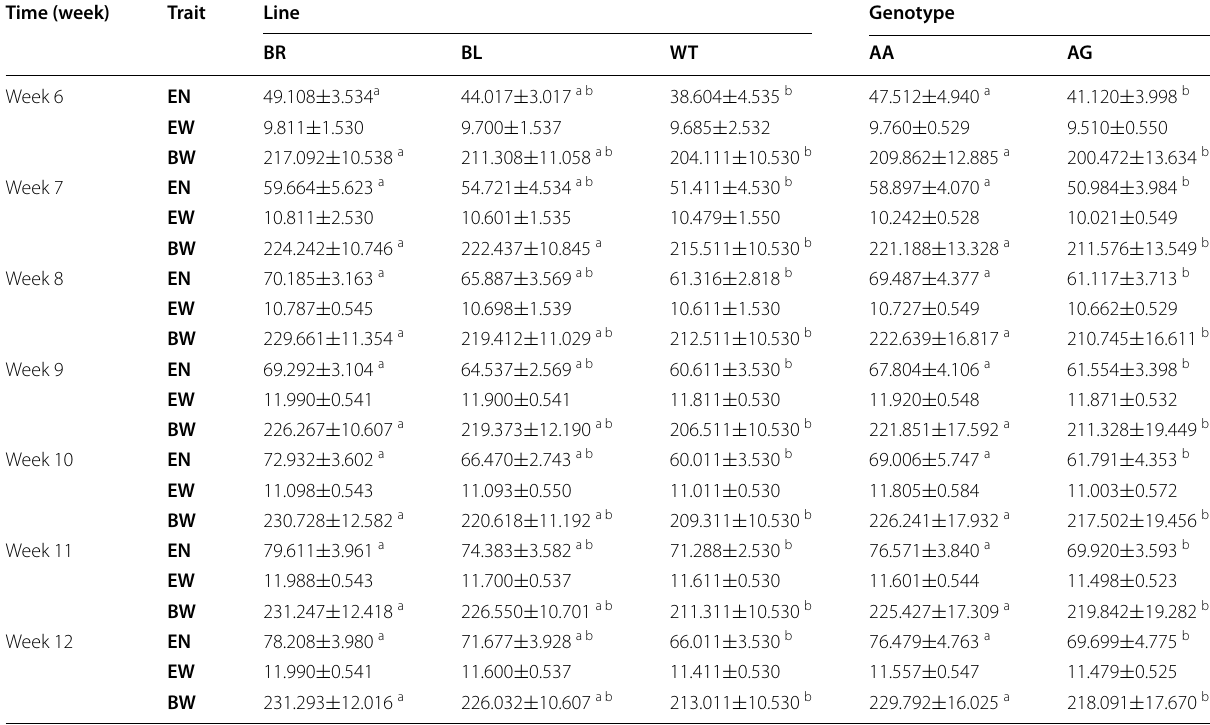
Table 5 Least square means ( SD) of the main effects of AA and AG genotypes and lines on egg production traits in three lines of ± Japanese